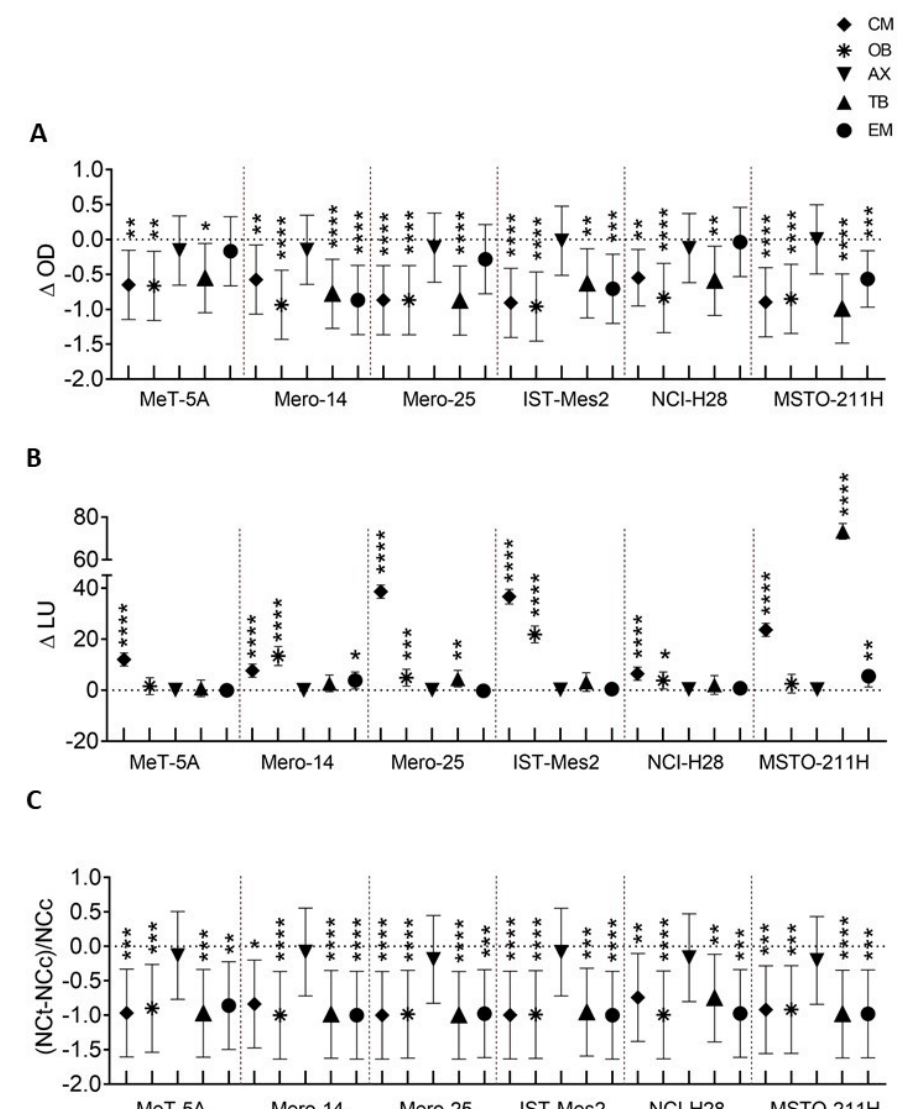
Figure 2. In vitro evaluation of CM (at 0.1 µ M), OB (at 0.1 µ M), AX (at 0.1 µ M), TB (at 1 µ M), and EM (at 0.1 µ M) in MeT-5A mesothelial cell line and in Mero-14, Mero-25, IST-Mes2, NCI-H28, and MSTO-211H MPM cell lines (depicted in the X -axis). ( A ) MTT assay for cell viability . Y -axis reports the average difference as dots (and its confidence interval as whiskers) between the optical densities (OD) measured after 72 h in treated and control cultures. The extended timeline graph is represented in Figures S2 (CM), S4 (OB), S6 (AX), S8 (TB), and S10 (EM). ( B ) Caspases’ activation assay for apoptosis . Y -axis reports the average difference ( ∆ LU as dots) and its confidence interval (as whiskers) between the units of luminescence obtained with the Caspase-Glo ® 3/7 assay and measured after 72 h in treated and control cultures. The extended timeline graph, representing the activation of caspases after 24, 48, and 72 h of treatment, is shown in Figures S3a (CM), S5a (OB), S7a (AX), S9a (TB), and S11a (EM). ( C ) CFA for clonogenic activity . The Y -axis reports the relative difference in the number of colonies counted in the treated (NCt) and control (NCc) cultures and expressed as (NCt-NCc)/NCc. Colonies were counted 11 days after the treatment. Counts were carried out with ImageJ digital processing software and a representative picture (for visual purposes only) can be found in Figures S3b (CM), S5b (OB), S7b (AX), S9b (TB), and S11b (EM). In ( A – C ), data are reported as the mean and its confidence intervals of three independent experiments. All datapoints with the confidence interval not encompassing the dotted line are statistically significant at various extents where * = p < 0.05; ** = p < 0.01; *** = p < 0.001, and **** = p <